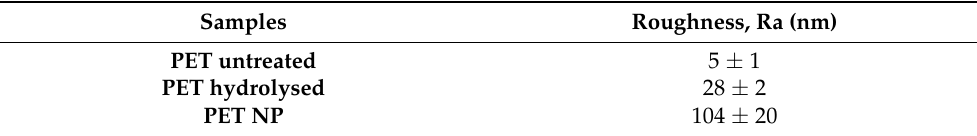
Table 2. Surface roughness values (Ra) of treated and untreated PET samples determined by AFM.